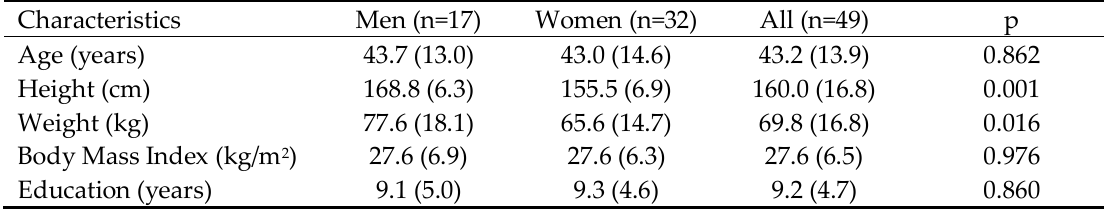
Table 1. Mean (standard deviations) of sample characteristics and t-test between genders